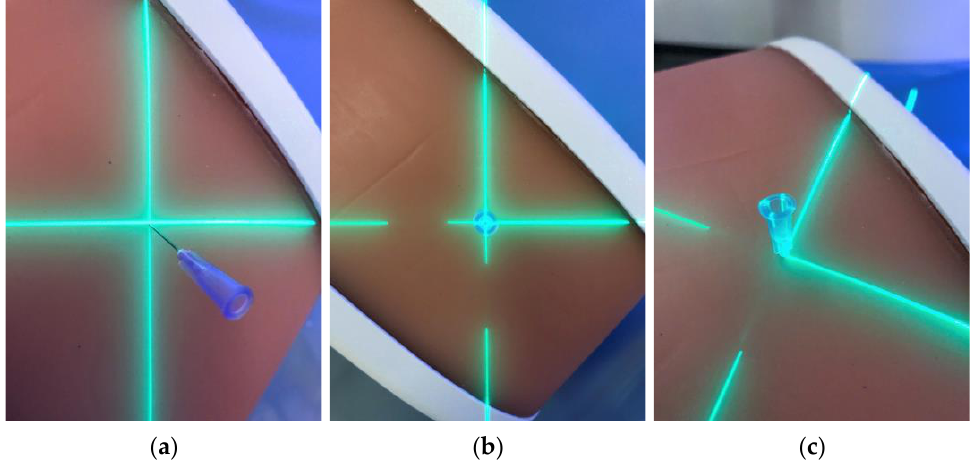
Figure 4. Fan beam laser projection onto the phantom and respective alignment of the needle ( a – c ). Precise alignment of the needle along the laser is paramount to achieve accurate needle placement.